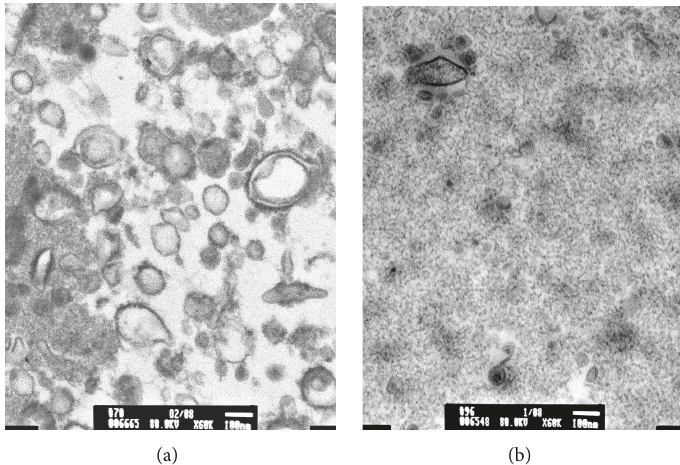
Figure 2: Transmission electron microscopy of urinary extracellular vesicles . Four mls of urine was used to isolate EVs by Amicon ultrafiltration (MW cutoff = 100,000 kD). EVs were fixed in 2.5% glutaraldehyde in 0.1M cacodylate buffer. Samples were stained with 1% osmium tetroxide in 0.1M cacodylate buffer and subsequently stained with 0.5% aqueous uranyl acetate. A JEOL 1200EX transmission electron microscope (JEOL, Peabody, MA) was used for observation and photography. 1A . EVs from HIV-1 posi.